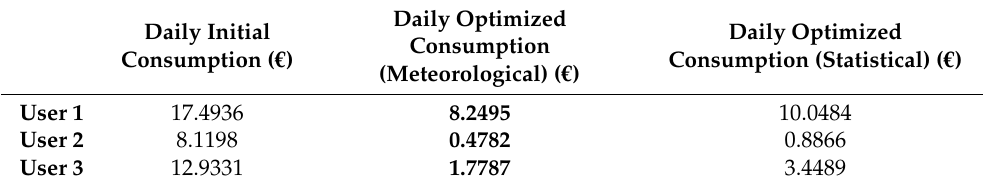
Table 1. Energy cost comparison.